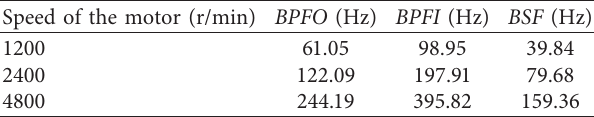
Table 2: Fault characteristic frequencies of rolling